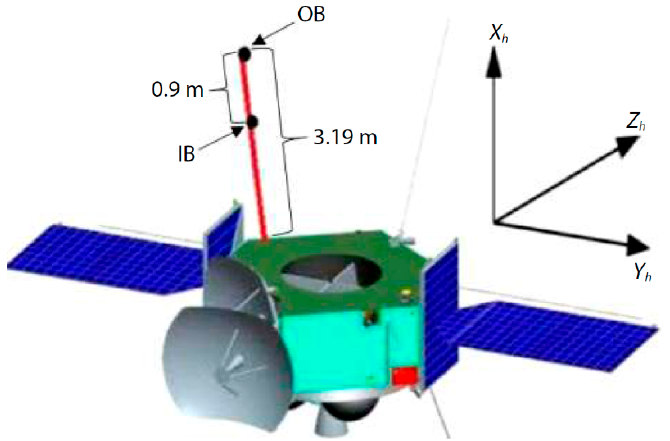
Figure 9. The schematic diagram of Tianwen-1 Mars orbiter and the dual-structure Mars Orbiter Magnetometer on it.